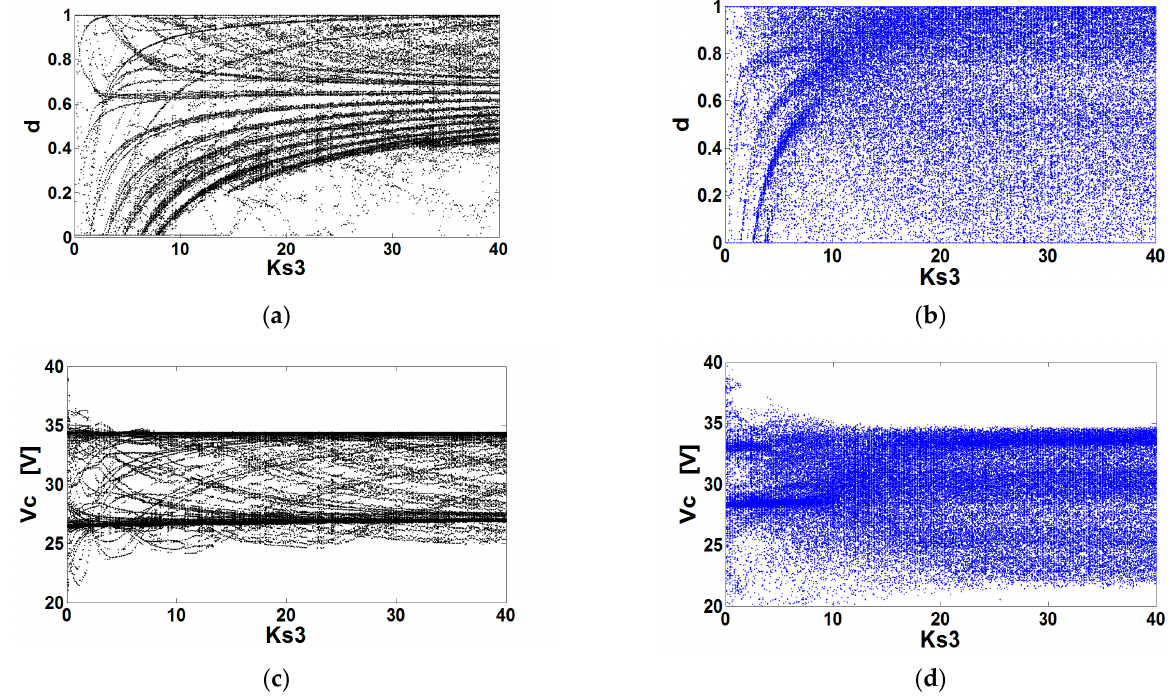
Figure 9. Bifurcation diagrams of the buck-motor system controlled with ZAD ( K S 1 = K S 2 = 2 K S 3 = 40, delay time 166.6 µ s, and quantization effects): ( a ) d vs. K S 3 numerical, ( b ) d vs. K S 3 experimental, ( c ) υ c vs. K S 3 numerical, and ( d ) υ c vs. K S 3 experimental.